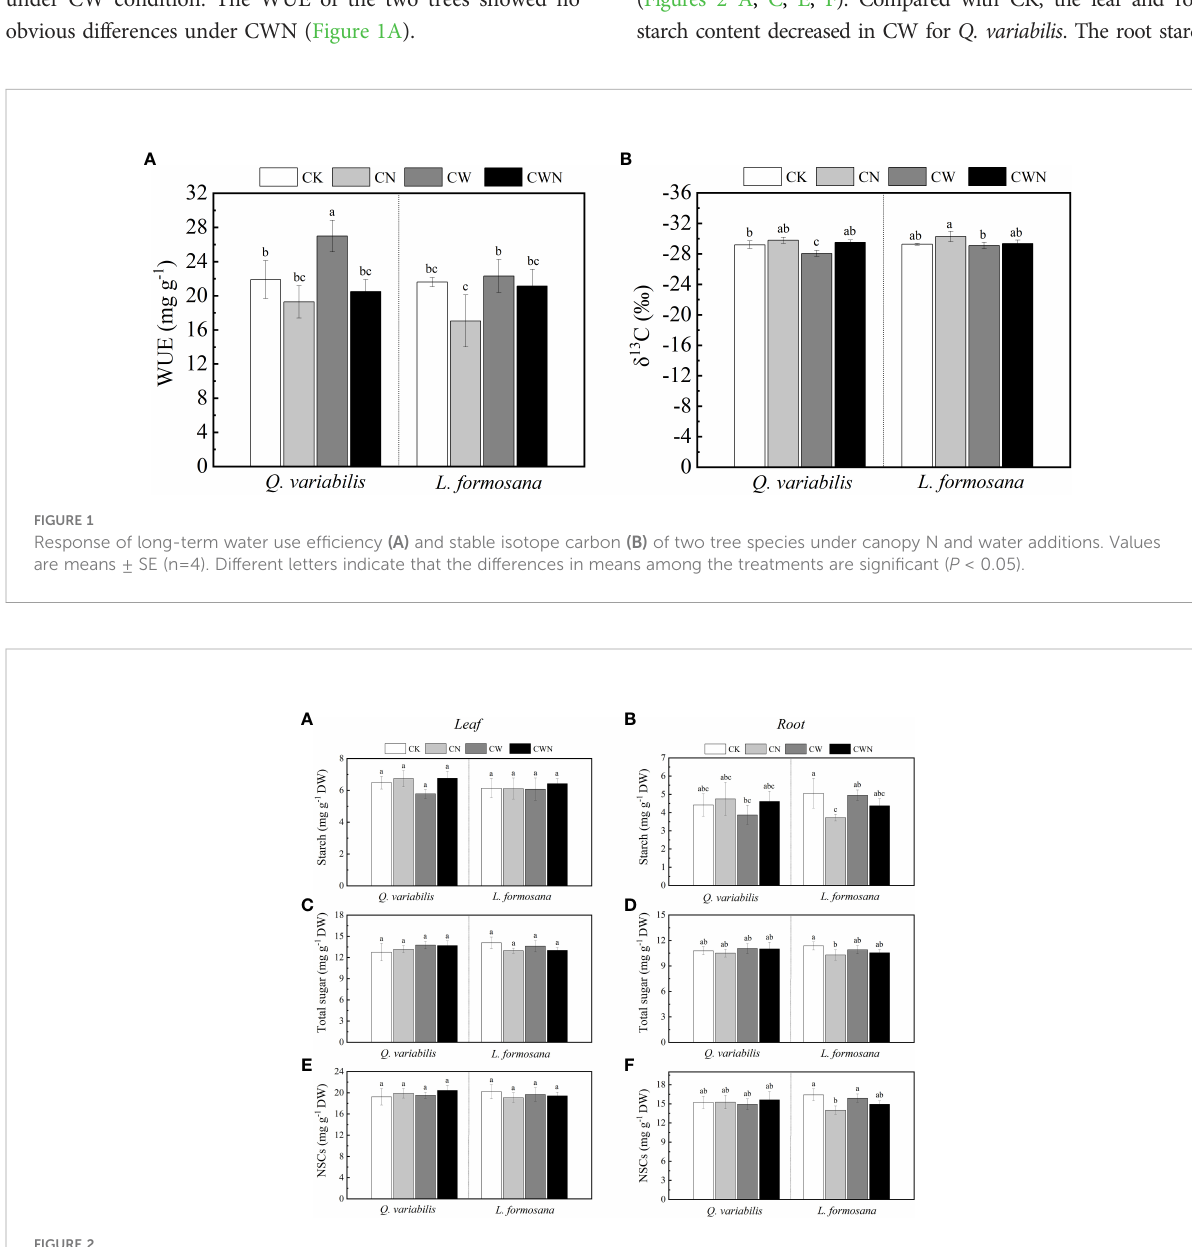
FIGURE 2 Changes in leaf and root starch (A, B) , leaf and root total soluble sugar (C, D) , leaf and root NSCs (E, F) concentration of two tree species under canopy N and water additions. Values are means ± SE (n=4). Different letters indicate that the differences in means among the treatments are signi fi cant ( P <